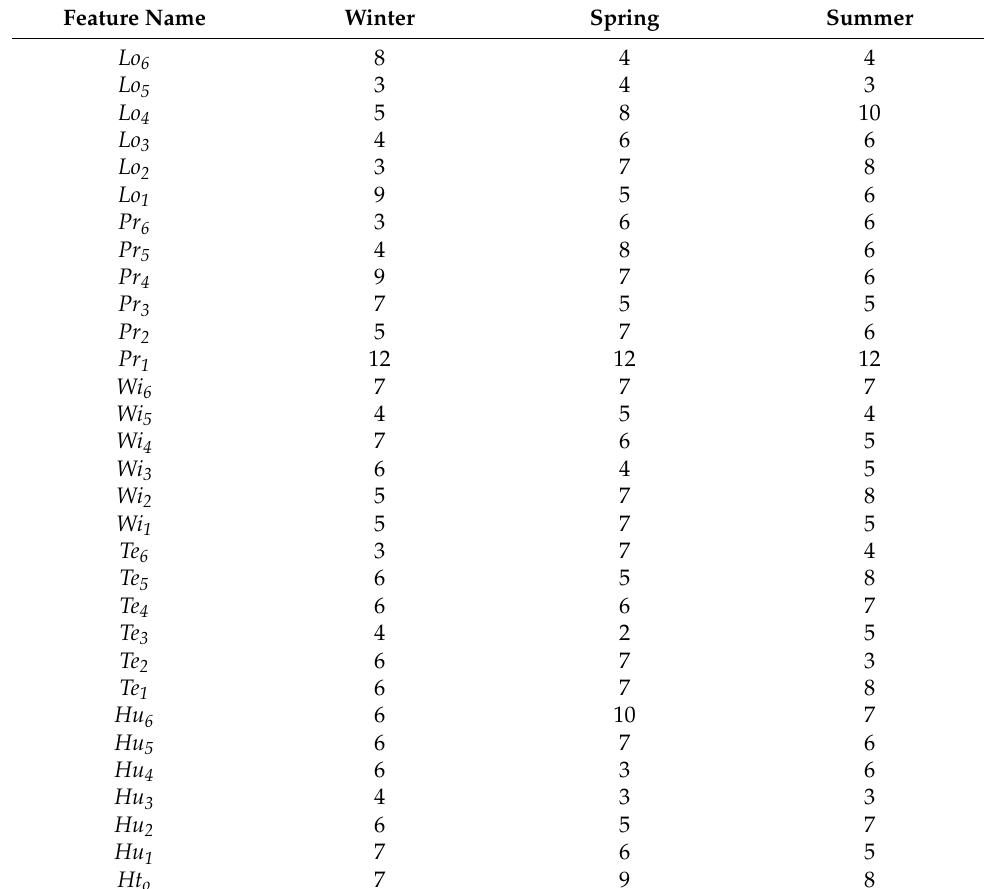
Table 3. Number of times a feature selected season